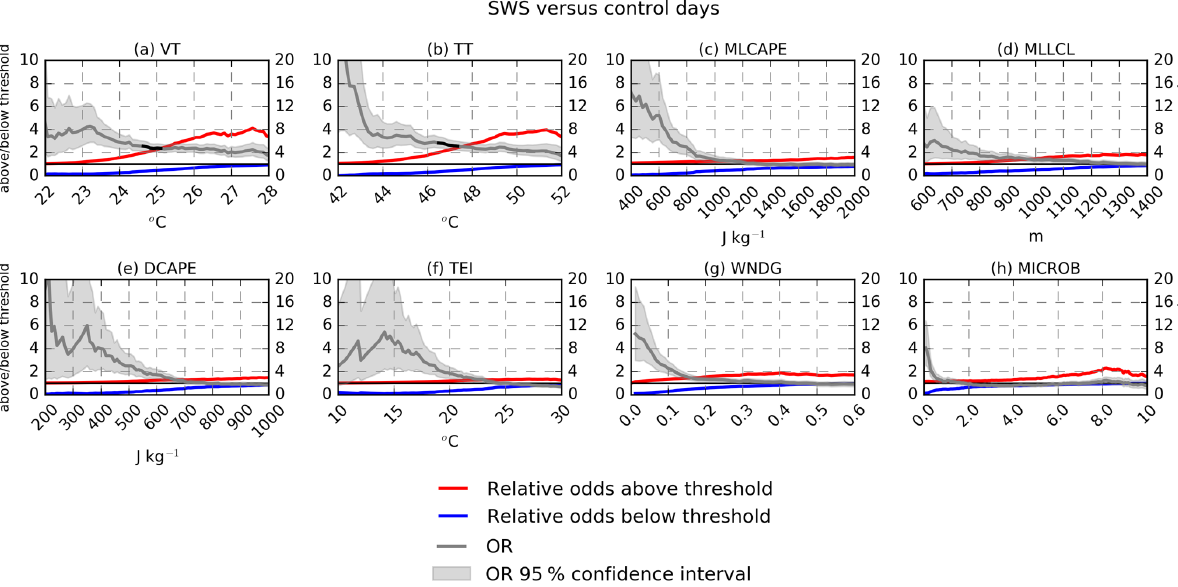
Figure 6. ORs for the same eight convective parameters shown in Fig. 5. Whenever the OR, defined by Eq. (2), results from a numerator (red) ≥ 2 and a denominator (blue) ≤ 0.5, then the OR is drawn in black. The left y axis expresses values corresponding to the OR’s numerator and denominator (red and blue lines), and the right y axis corresponds to the OR value (gray line). At very low and very high threshold values, the variance of the OR may be undefined, and the 95% OR confidence interval cannot be